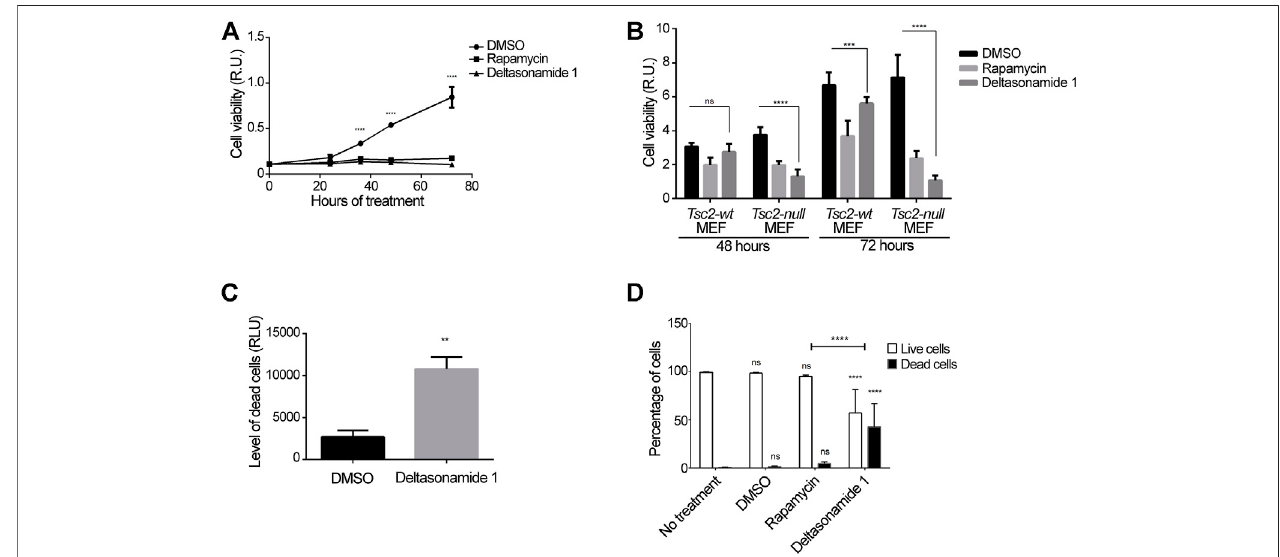
FIGURE5| ProlongedDeltasonamide1treatmentincreases Tsc2-null MEFsdeath (A) . Tsc2-null MEFstreatedwithDMSO, rapamycin (20nM),orDeltasonamide 1 (6 µM) for 24 h up to 72 h. After treatment, cell viability was measured by XTT assay (B) . Tsc2-wt and Tsc2-null MEFs treated with DMSO, rapamycin (20 nM) or Deltasonamide 1(6 µM)for48and 72h. Aftertreatment,cell viabilitywasmeasured byXTTassay (C) . Tsc2-null MEFstreated withDMSO orDeltasonamide1(6 µM)for 48 h. After treatment, number of dead cells was estimated using the CytoTox-GloTM kit Live/DeadTM assay (D) . Tsc2-null MEFs treated with DMSO, rapamycin (20 nM), or Deltasonamide 1 (6 µM) for 48 h. Live and dead cells with each drug treatment were marked with Live/DeadTM Fixable Green Dead Cell staining assay and analyzed with an automated cell counter. Results are representative of at least three independent experiments. Data are expressed as the mean ± SD ( p < 0.05).